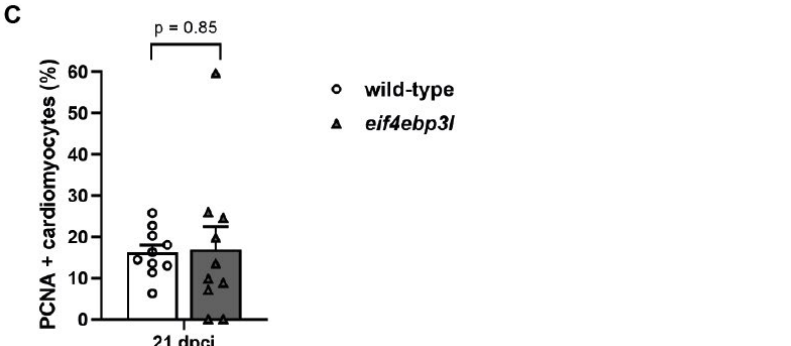
Figure 6. Comparison of cardiomyocyte (CM) proliferation of Tg(fli1:eGFP/hsp70l:eif4ebp3l-p2A- tdTomato) and wild-type siblings at 21 dpci. ( A – B’ ) Representative immunofluorescence images of cardiac tissue of wild-type and Tg(fli1:eGFP/hsp70l:eif4ebp3l-p2A-tdTomato ) at 21 dpci. Mef2 marks CM nuclei in green and PCNA nuclei of proliferating cells in red. PCNA–positive CMs are indicated with white arrowheads, and insets are magnified views of the marked cells. Dashed lines highlight the approximate border of the injured area. ( C ) Quantification of proliferating CMs expressing PCNA within 150 µm from the injury border. Values are mean ± SEM, n = 10 per group. Scale bar = 100 µm.